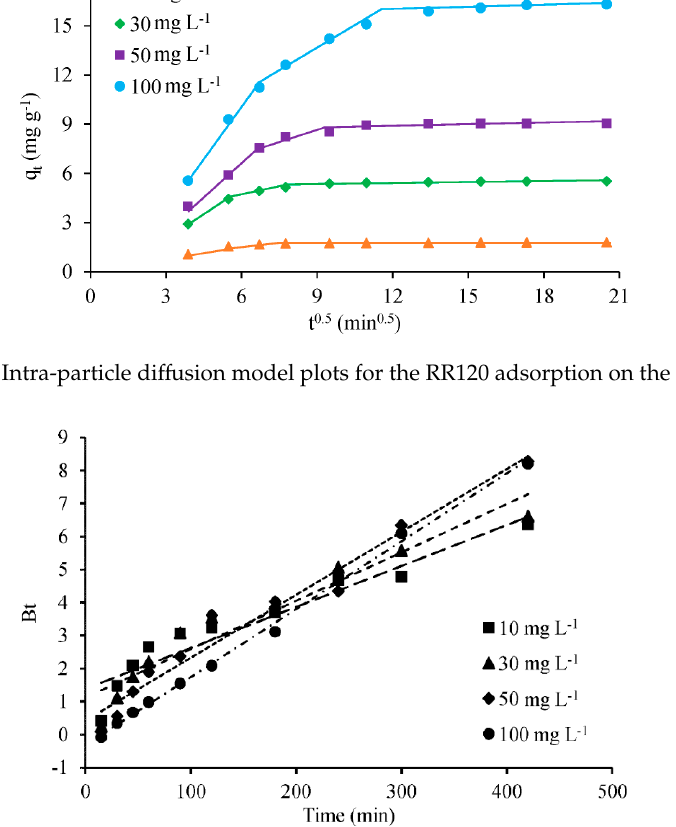
Figure 8. Boyd’s kinetic parameters for the adsorption of RR120 on the MCC.